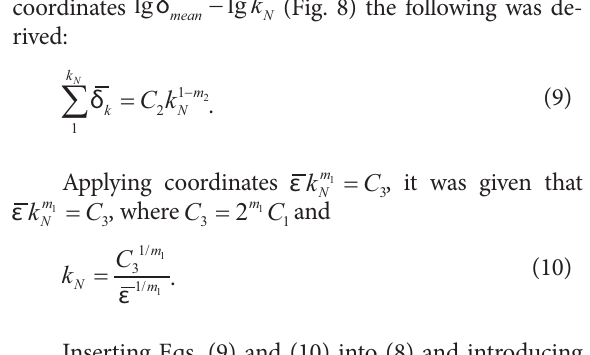
Fig. 8. Low cycle lifetime curves for strain controlled